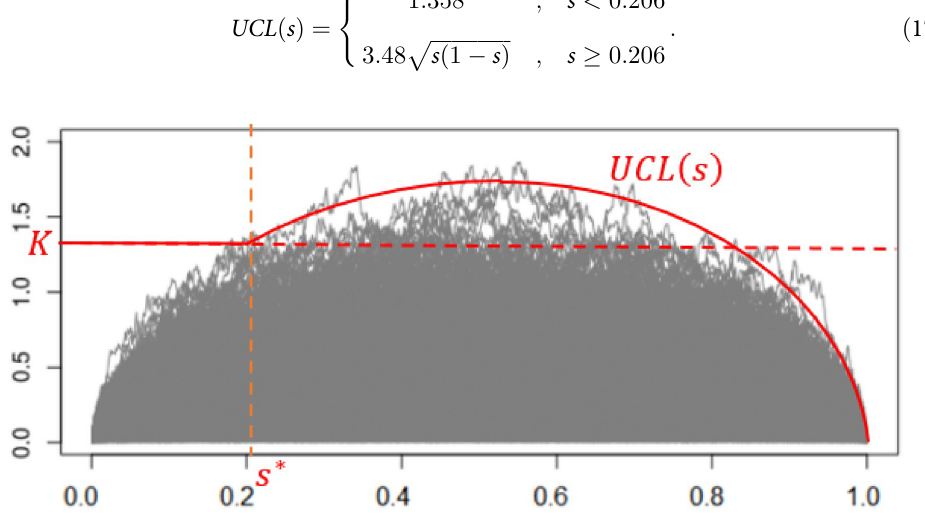
Fig 6. The upper control limit of T s for α =